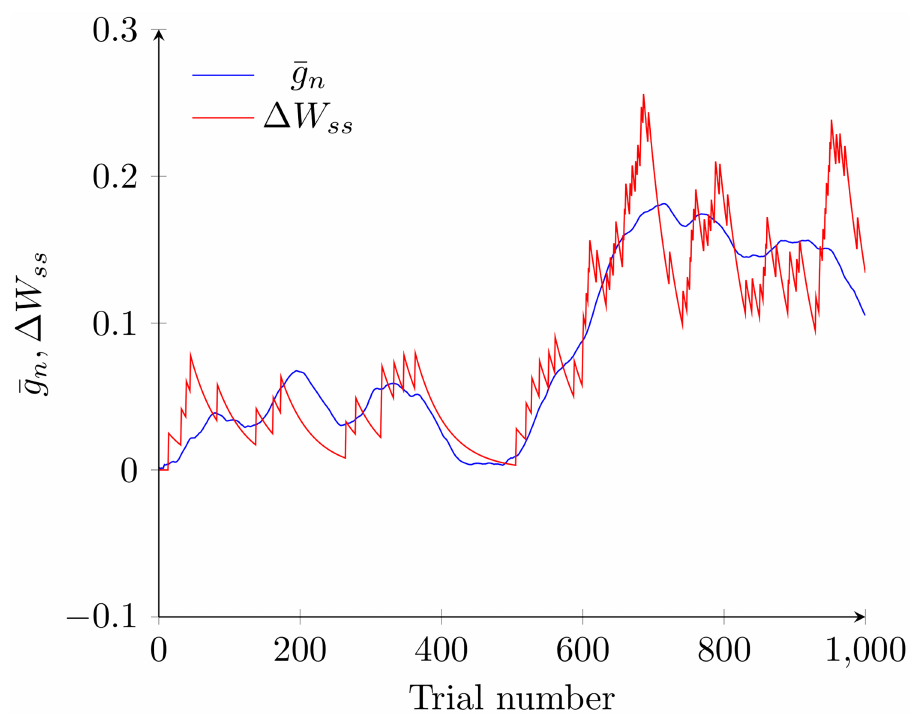
. We compare Δ W ss and g to verify that they follow each n n